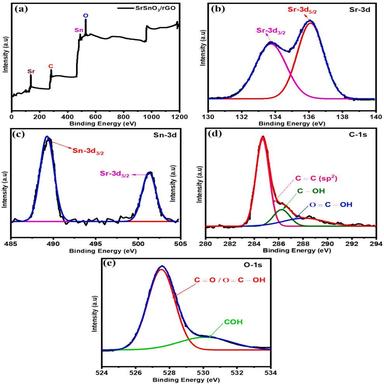
(a) Survey spectrum of SrSnO3/rGO nanohybrid, High resolution spectra of (b) Sr-3d, (c) Sn-3d, (d) C-1s and (e) O-1s.